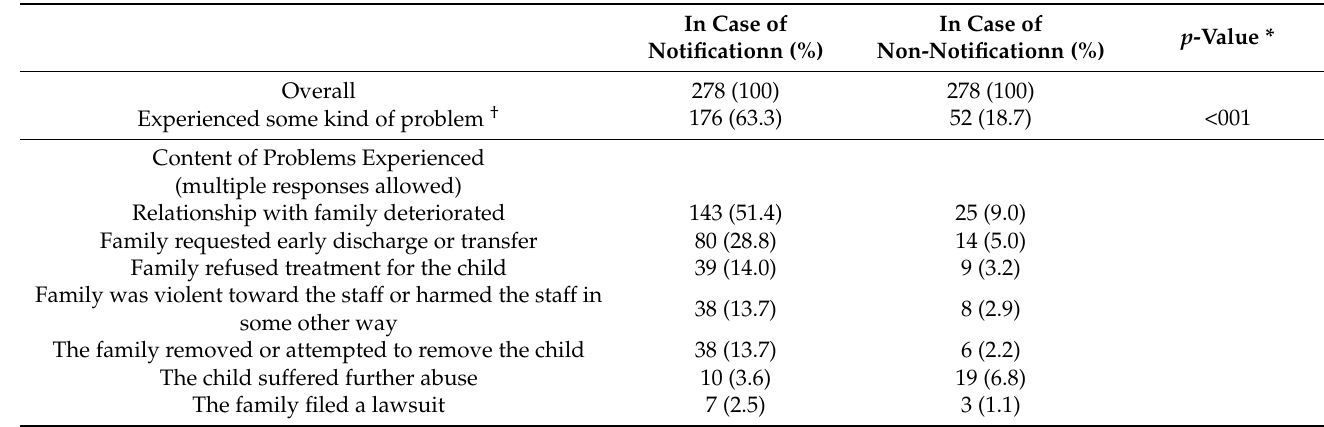
Table 4. Difficulty experienced with and without notification, n